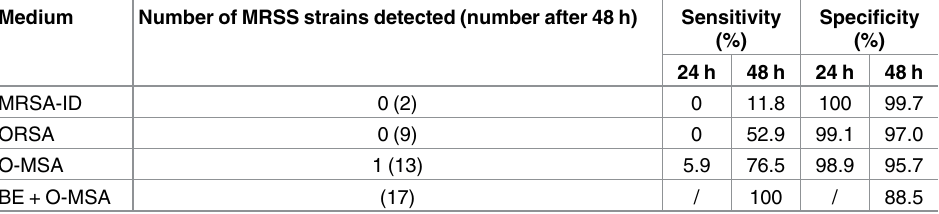
Table 5. Comparison of direct inoculation of MRSA-ID, ORSA, oxacillin-MSA and broth enrichment (BE) prior to inoculation on oxacillin-MSA in detection of methicillin-resistant Staphylococcus sciuri (MRSS) verified by identification by automated Vitek2 System and mecA PCR.